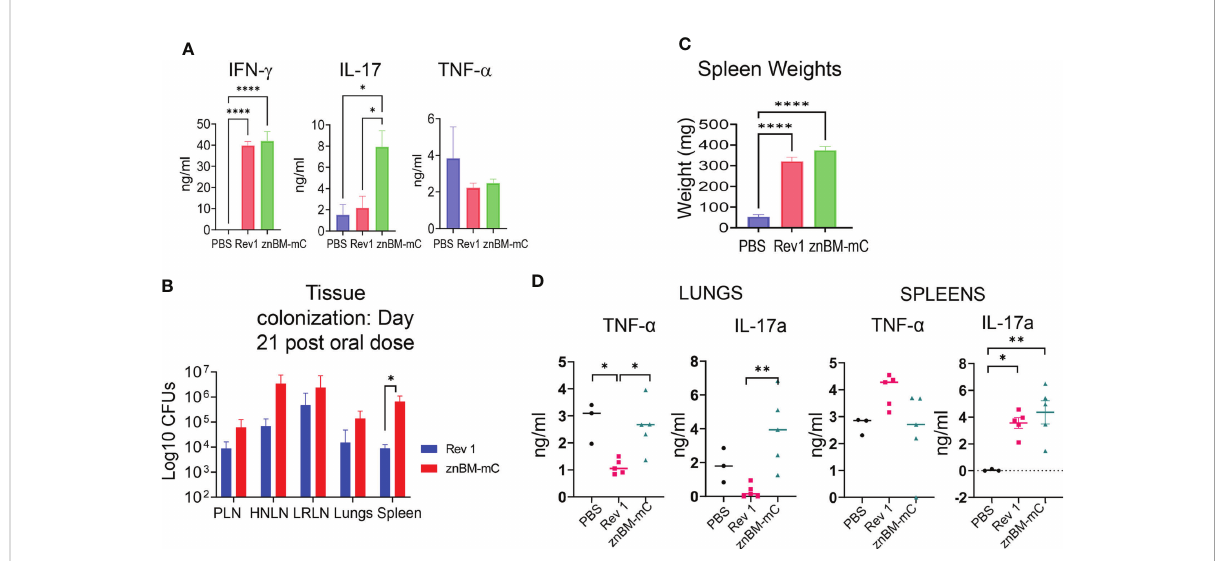
FIGURE 6 IFN- g is required for vaccine clearance and predominates the proin fl ammatory cytokine response in the lungs post-vaccination. (A) Groups of BALB/ c mice (5 – 7 mice/group) vaccinated with Rev 1 or znBM-mC or naïve controls using the previously described protocol, and evaluated for cytokine responses on day 56. Total lung mononuclear cells were restimulated in vitro with Brucella Ag for 72 h and cytokine ELISAs for IFN- g , IL-17a, and TNF- a were performed on collected supernatants; ****p <0.0001, *p <0.05. (B) Tissue colonization of peripheral lymph nodes (PLNs), head and neck LNs (HNLNs), lower respiratory LNs (LRLNs), lungs, and spleens were evaluated 21 days after oral immunization of IFN- g − / − mice with Rev 1 or znBM-mC; *p <0.05. (C) The extent of splenic in fl ammation in IFN- g − / − mice was measured 21 days after oral vaccination with sPBS, Rev 1, or znBM-mC; ****p <0.0001 vs. PBS-dosed mice. (D) Cytokine levels in splenic and lung lymphocyte culture supernatants. Groups of IFN- g − / − mice ( fi ve mice/group) vaccinated with a single oral dose or sPBS, Rev 1, and znBM-mC as previously described protocol were euthanized on day 21. Splenic and lung lymphocytes were restimulated in vitro with Brucella Ag for 72 h and cytokine-speci fi c ELISAs for IFN- g , IL-17a and TNF- a were performed on collected supernatants. One-way ANOVA was used to compare group means. *p <0.05; **p <0.005. Experiment in (A) was repeated twice, and experiments in (B – D) were performed